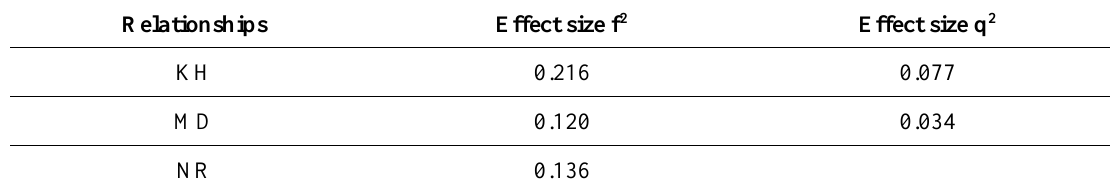
Table.6. summary of effect sizes of f 2 and q